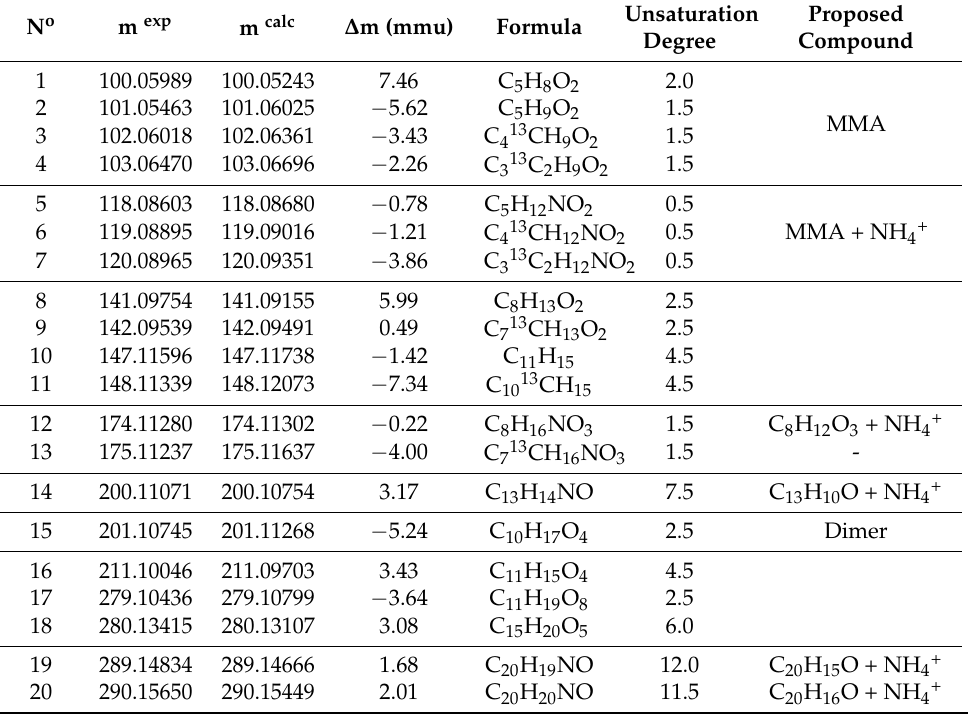
Table 2. Fragments resulted from the isothermal decomposition of the